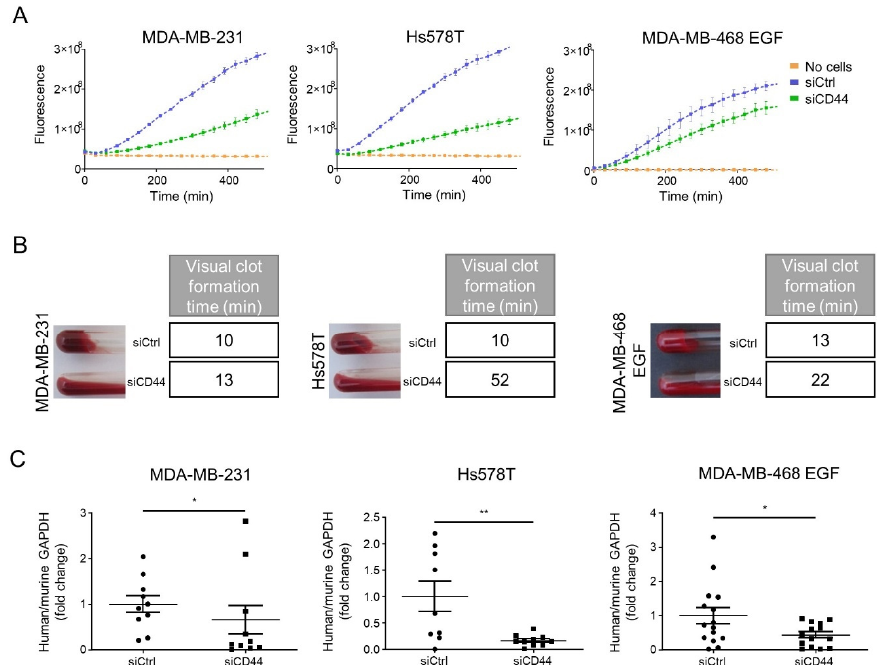
Figure 3. CD44 silencing decreases in vitro coagulant properties and metastatic seeding in vivo: ( A ) Enzymatic fluorescent coagulation assays and ( B ) visual clot assays performed with EMT + MDA- MB-231, Hs578T and EGF-treated MDA-MB-468, and transfected with a pool of 3 siRNAs directed against CD44 (siCD44) or 3 non-targeting siRNAs (siCtrl). ( C ) To quantify metastatic seeding, RT- nested qPCR for human GAPDH was performed on total RNA extracted from the lungs of mice injected intravenously for 24 h with MDA-MB-231, Hs578T or MDA-MB-468 induced to EMT by EGF, and silenced (siCD44) or not (siCtrl) for CD44 in vitro before injection. Results are expressed as the ratio of human GAPDH (normalized to mouse GAPDH) for each mouse to the mean value of the reference group (siCtrl). Two independent experiments were pooled: MDA-MB-231 (siCtrl n = 10, siCD44 n = 10), Hs578T (siCtrl n = 9, siCD44 n = 10) and MDA-MB-468 treated with EGF (siCtrl n = 15, siCD44 n = 14). *, p < 0.05; **, p < 0.01.